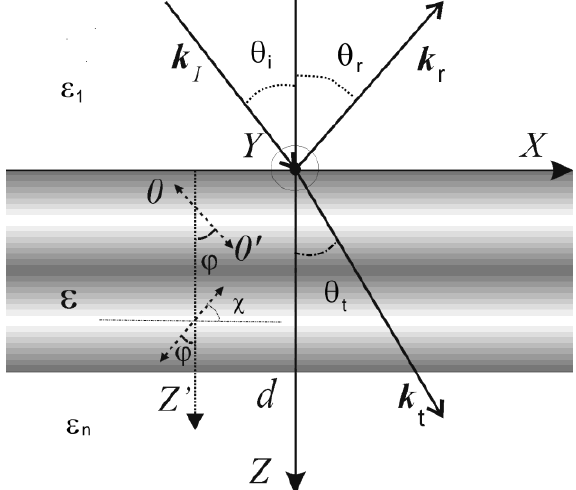
Fig. 1 . The plane of incidence of light on an anisotropic inhomogeneous layer with torsion of the optical axis. Angle of incidence is